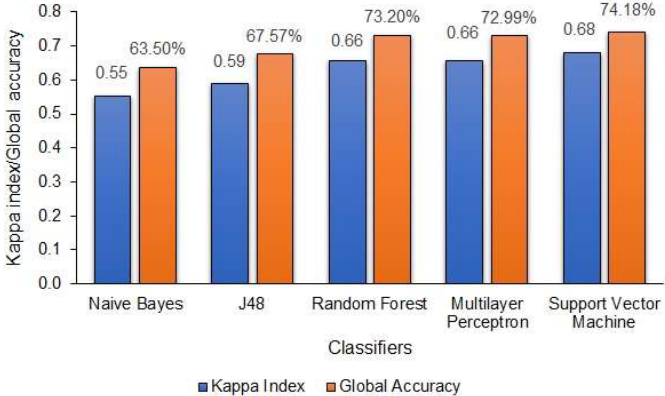
Figure 6. Kappa index and global accuracy per classifier with nine classes and 200 training samples.